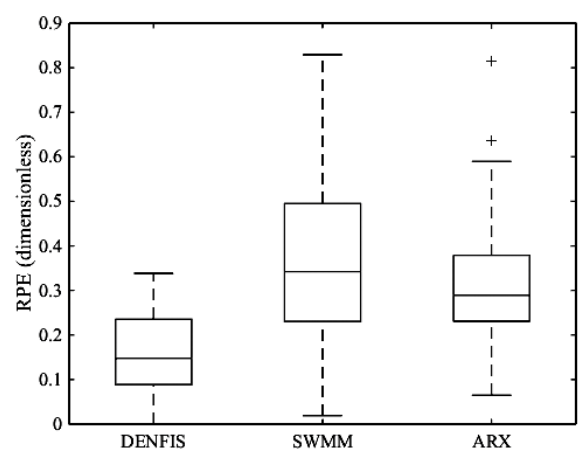
Figure 7. Comparison of RPE values for selected peak water levels simulated by DENFIS and SWMM models in Dandenong catchment.